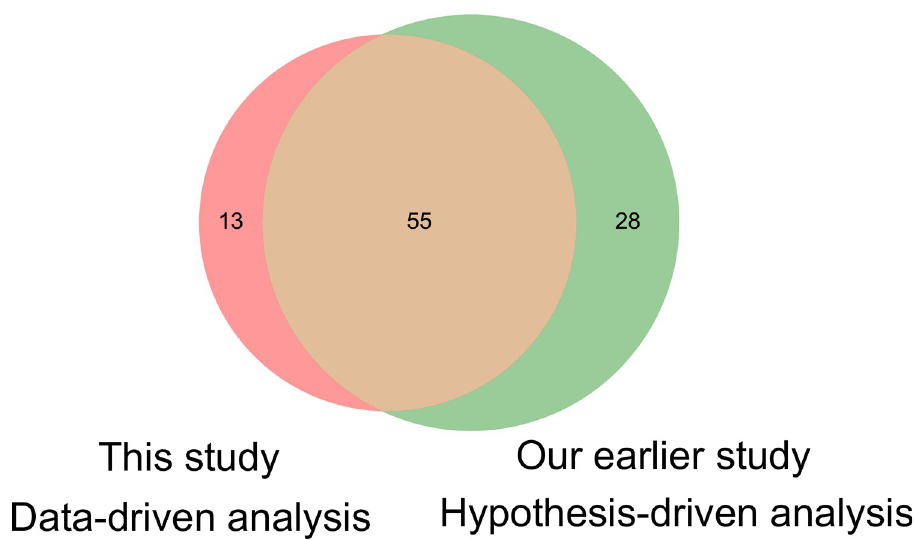
Fig 5. Molecules targeted in the hypothesis-driven and data-driven analyses. Venn diagram of molecules targeted in our earlier study [4] and extracted molecules in this study. The molecules included in each Venn diagram are listed in S4